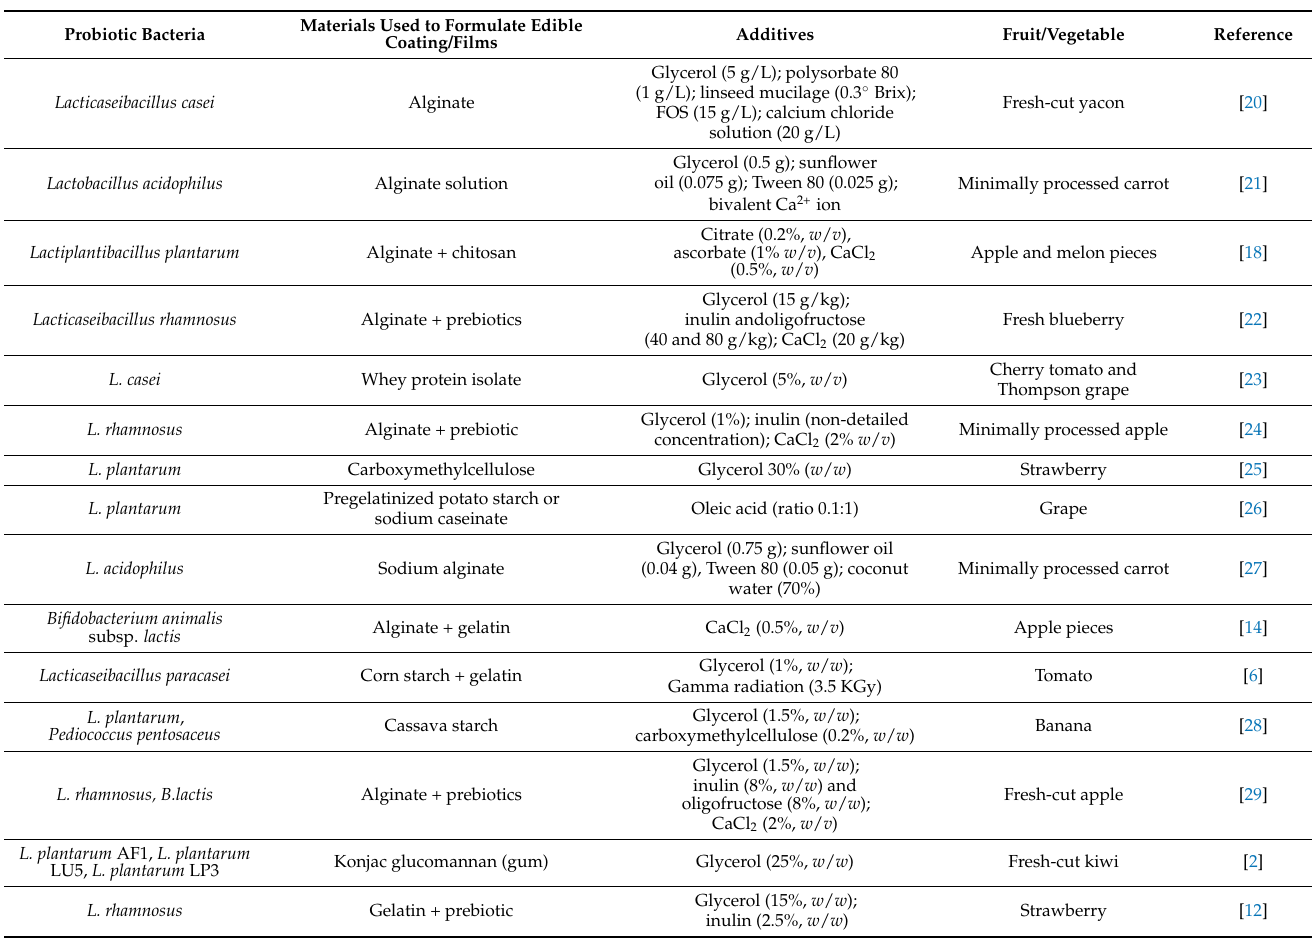
Table 1. Materials used to formulate probiotic-loaded edible films/coatings applied to fresh or minimally processed fruit and